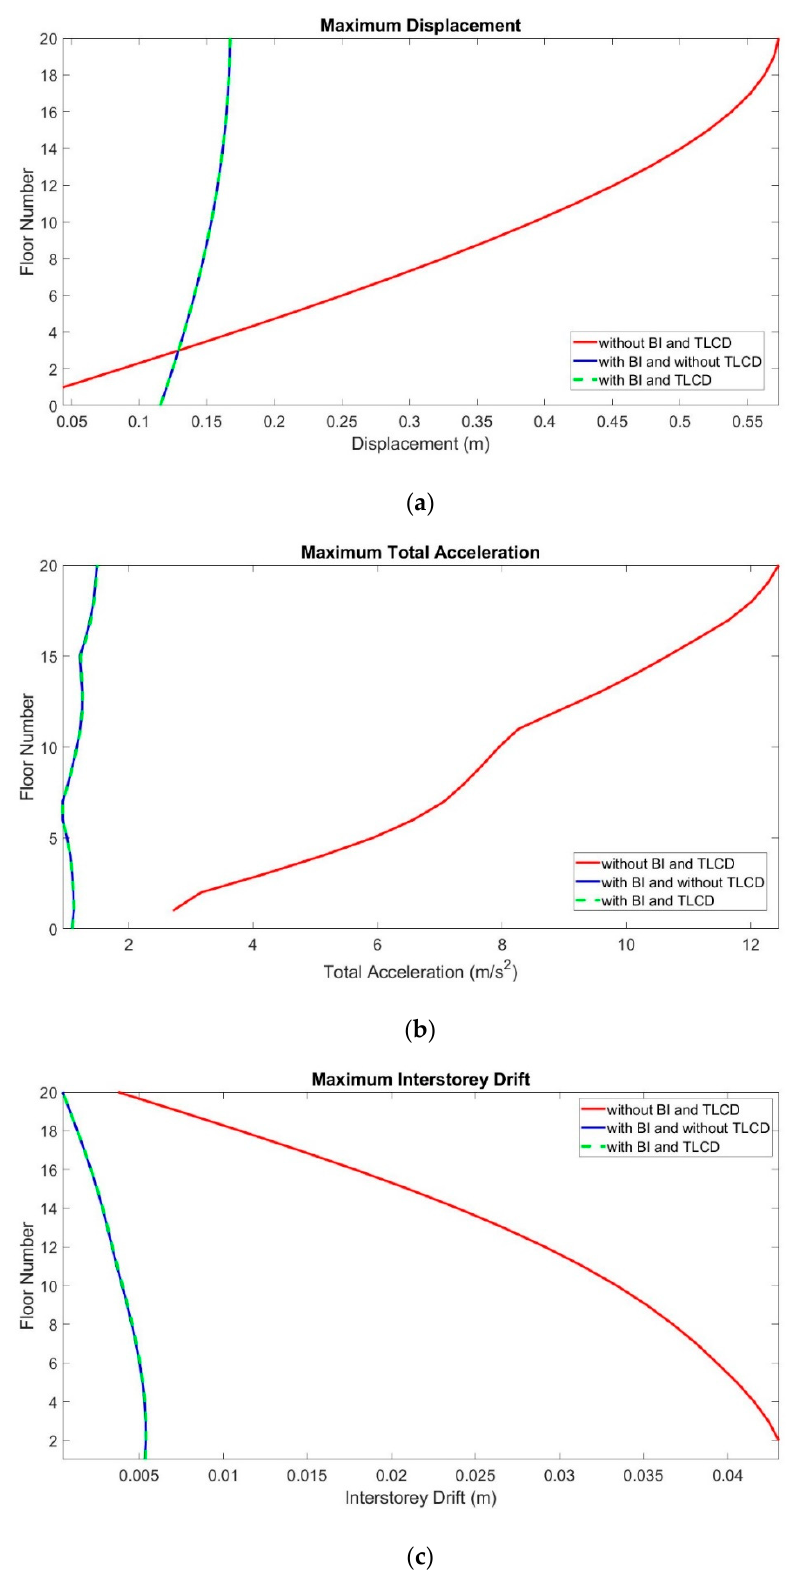
Figure 4. Peak responses for a hybrid-controlled structure, base-isolated structure, and simple uncontrolled structure subjected to earthquake no. 21 record: ( a ) maximum displacement; ( b ) maximum total acceleration; ( c ) maximum interstory drift.